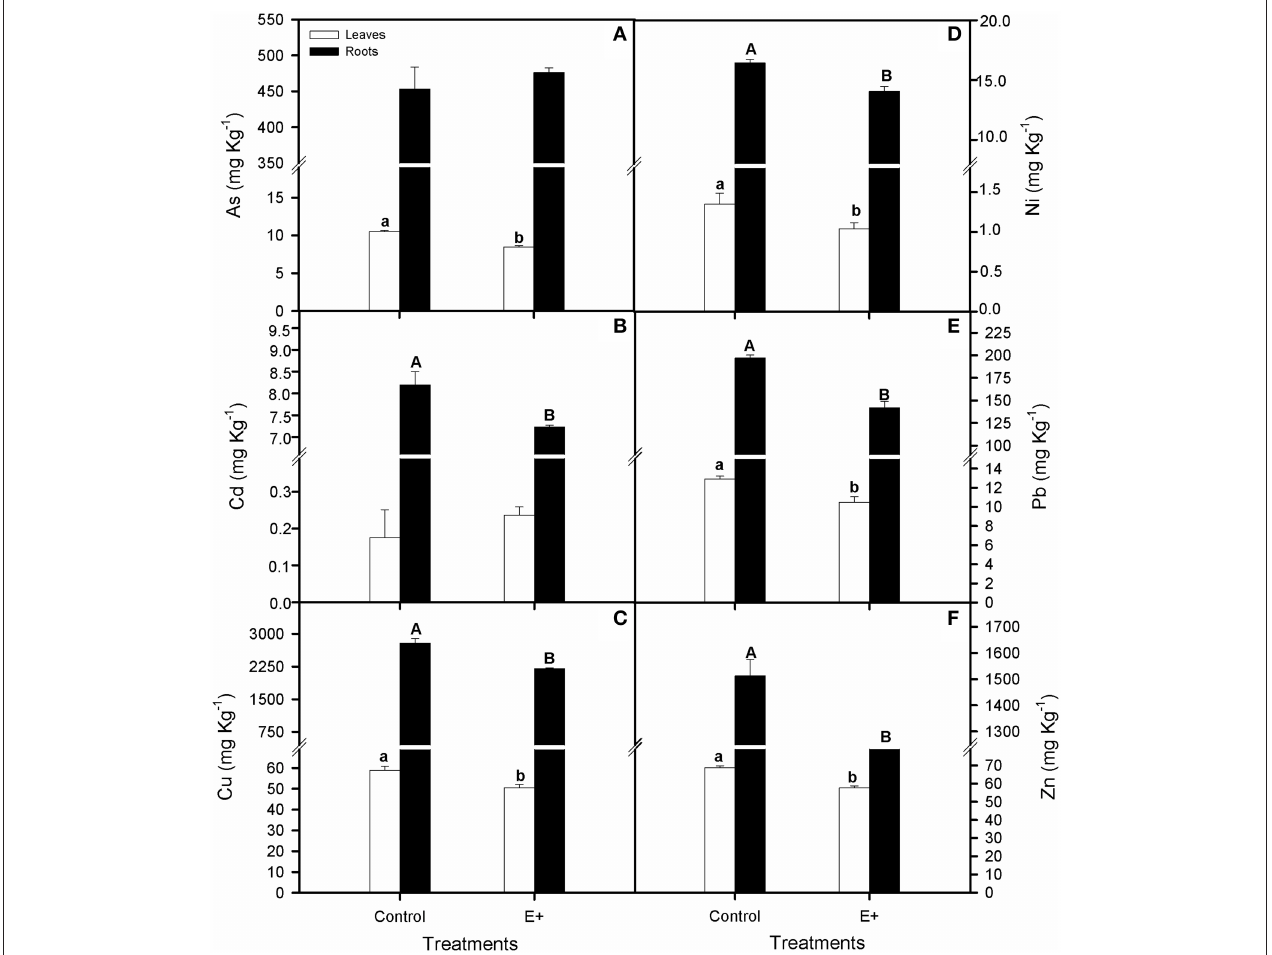
FIGURE 7 | Effect of inoculation with the endophytic bacterial consortium on total arsenic (A), cadmium (B), copper (C), nickel (D), lead (E), and zinc (F) for leaves and roots of Spartina maritima plants grown in natural soil from Tinto marsh for 30 days. Values are means ± s.e. ( n = 10 ). Different capital letters indicate statistical differences between inoculation treatments in roots and different lower case letters in leaves ( P < 0.05 ).